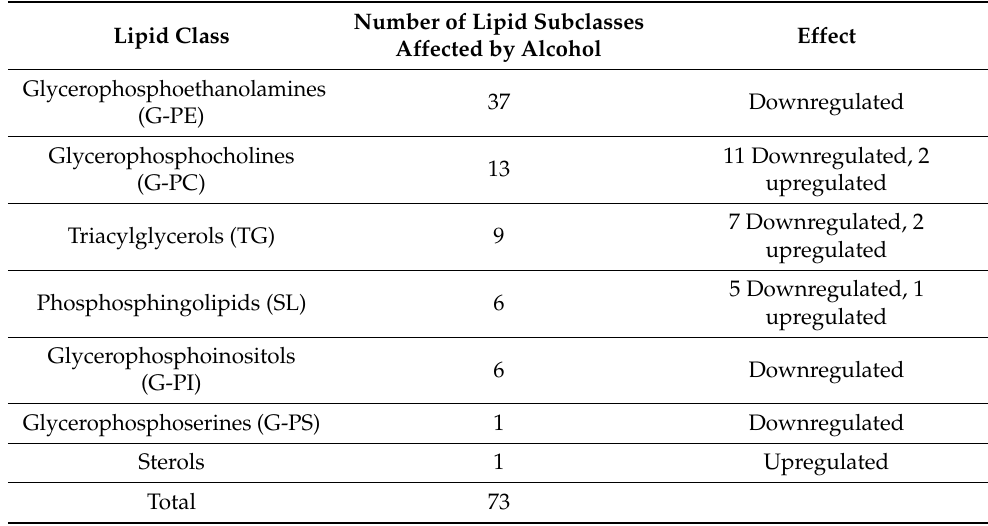
Table 2. Class of lipids and their corresponding lipid subclass number, which was significantly altered following alcohol exposure in an untargeted lipidomic